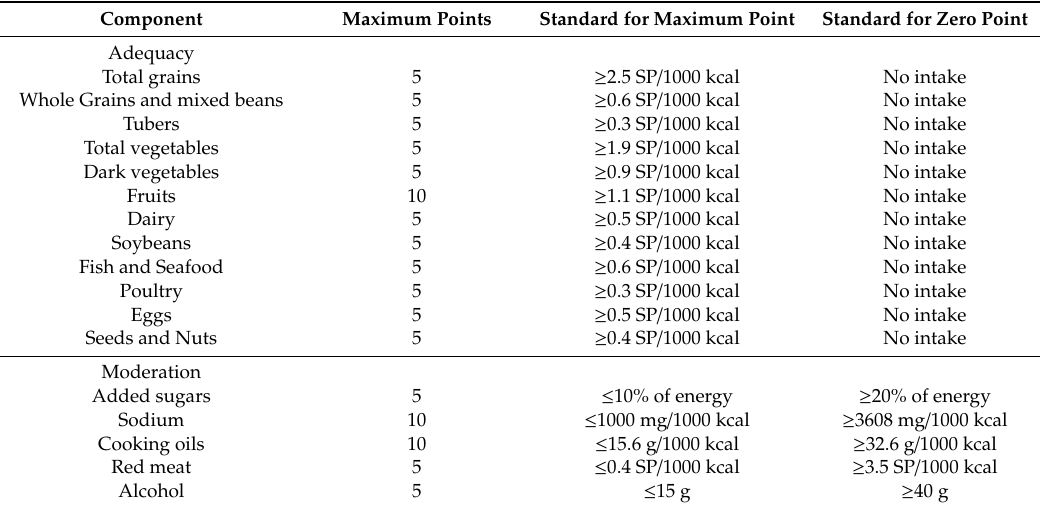
Table 1. Components of the Chinese Healthy Eating Index (CHEI) and scoring method